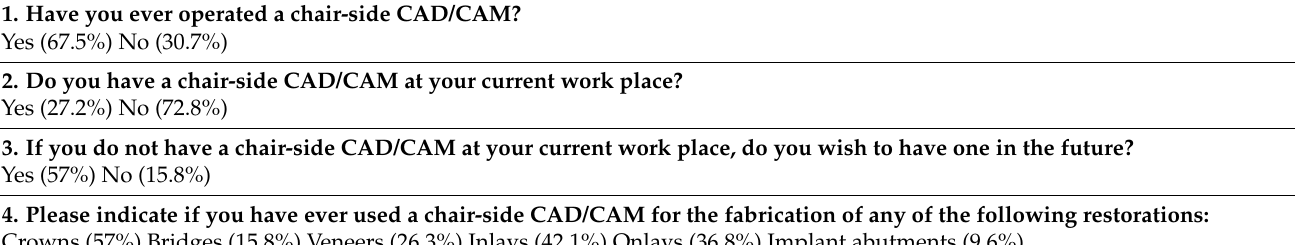
Table 2. Response of participating dentists to practice-related questions (No. =